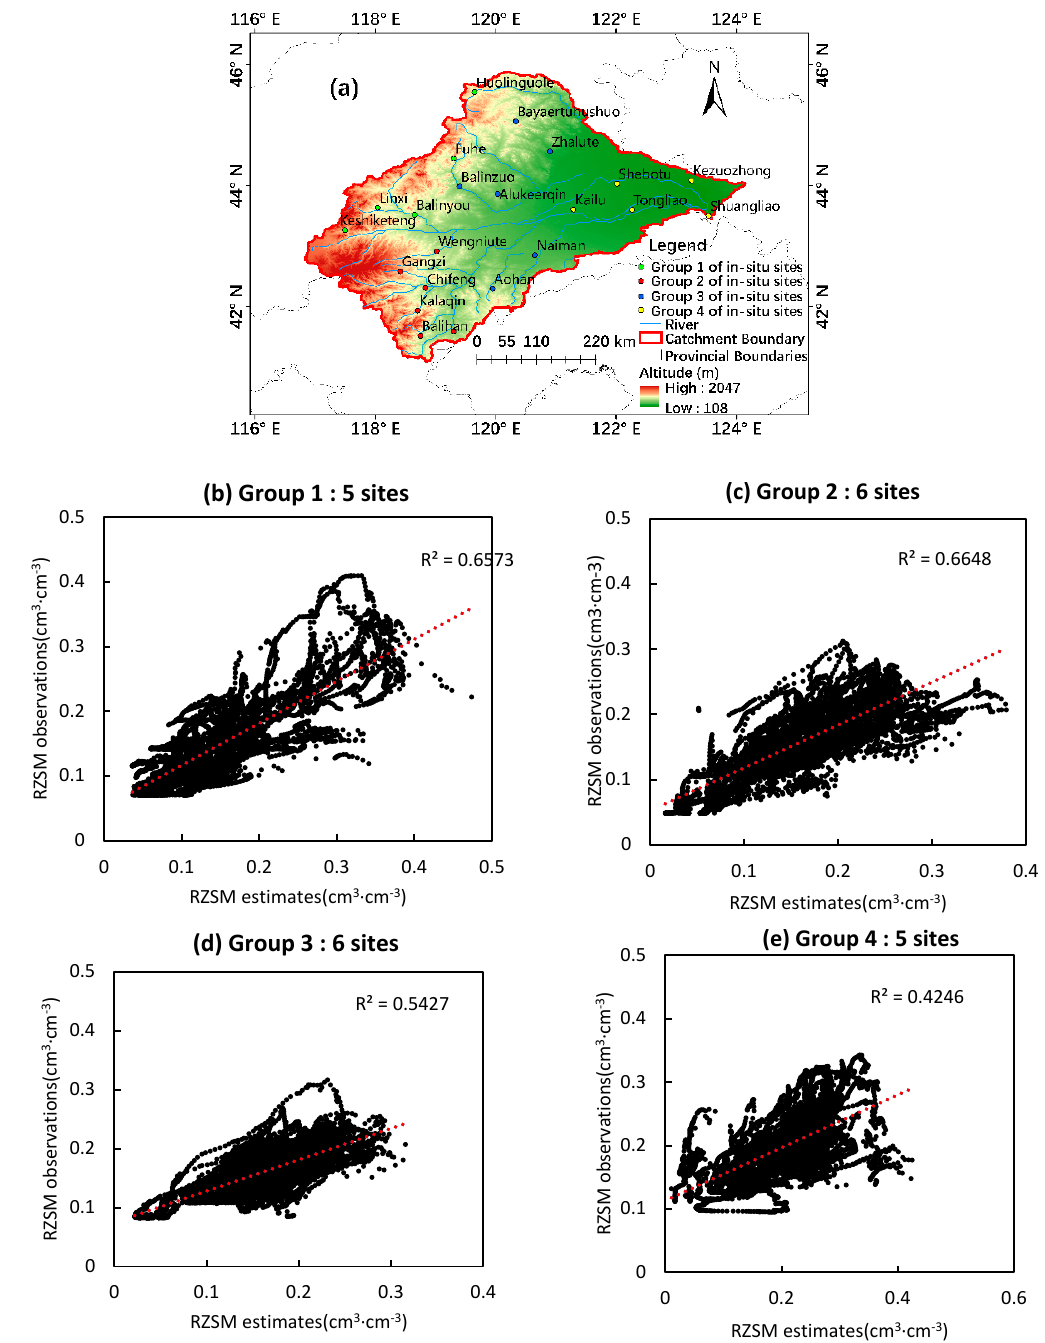
Figure 8. Scatterplots of the root-zone soil moisture observations and estimates during the calibration periods (2016–2020) at each of the four groups of in situ sites in the Xiliaohe River Basin. ( a ) Locations of the four groups of in situ sites, ( b ) Group 1, ( c ) Group 2, ( d ) Group 3 and ( e ) Group 4. According to the time series of the estimated and observed RZSM (Figure 3a,b), the